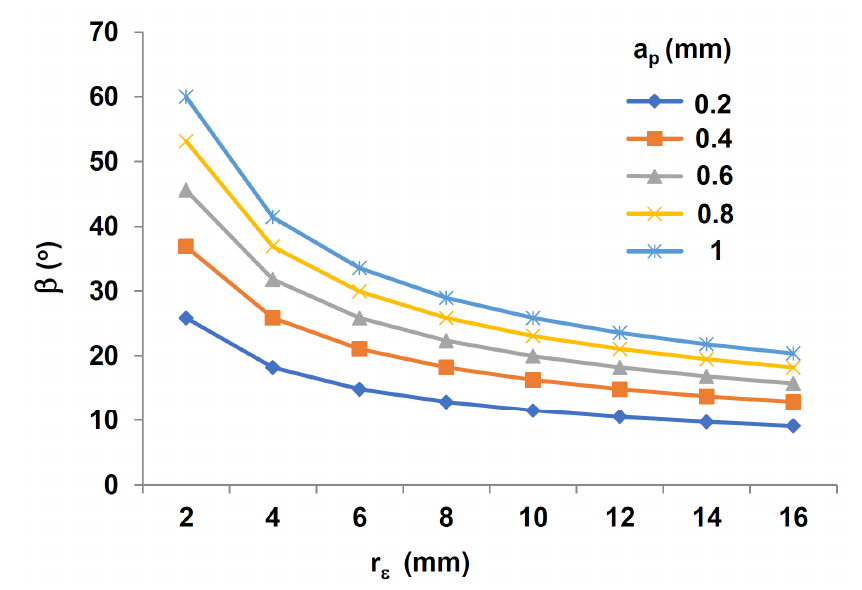
Figure 4. Effect of insert radius r ε and a p on angle β .